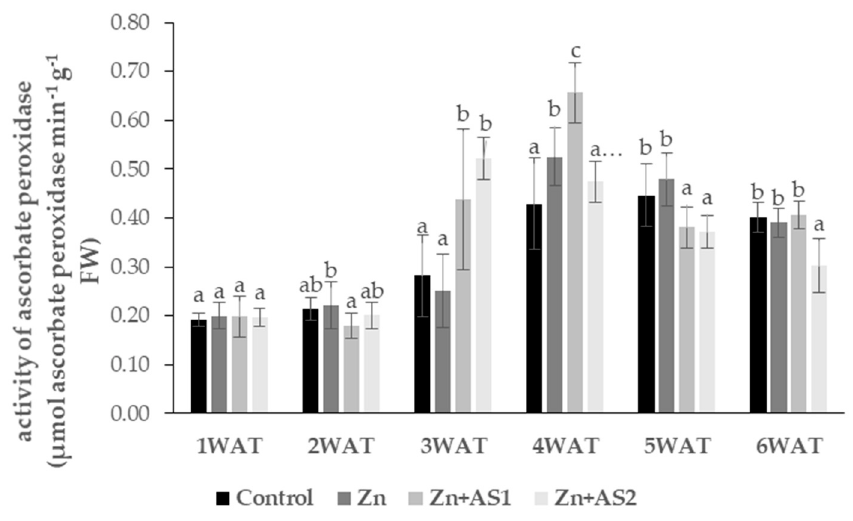
Figure 9. The effect of different foliar treatments (Zn, Zn+AS1, and Zn+AS2) on the activity of ascorbate peroxidase, n = 12 ± S.D. Lower case letters (a, b, and c) show the significant differences among treatments based on the independent t-test ( p < 0.05). AS: amino acid; FW: fresh weight; Zn: zinc; WAT: week(s) after treatment.